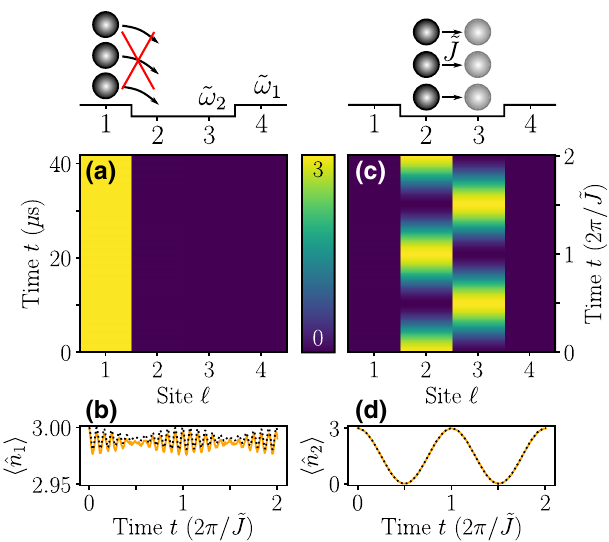
FIG. 2. Edge localization and slow collective hopping of a boson stack. (a),(c) The local occupations (cid:2)ˆ n (cid:3) (cid:3) as a function of the site index (cid:3) and time t . (b),(d) The occupation of the site (cid:3) = 1 (b) and the site (cid:3) = 2 (d) as a function of time t , simu- lated using the full Hamiltonian of Eq. (1) (solid yellow) and the effective Hamiltonian of Eq. (14) (dotted black). The initial state is | 3 1 (cid:3) = | 3000 (cid:3) in (a)–(b) and | 3 2 (cid:3) = | 0300 (cid:3) in (c)–(d). The simulation parameters in this and all the following figures are J / 2 π = 10 MHz and U / 2 π = 250 MHz. Note the two time axes in (a),(c), one in SI units (left axis) and the other in the natural units 2 π/ ˜ J of the effective hopping rate (right